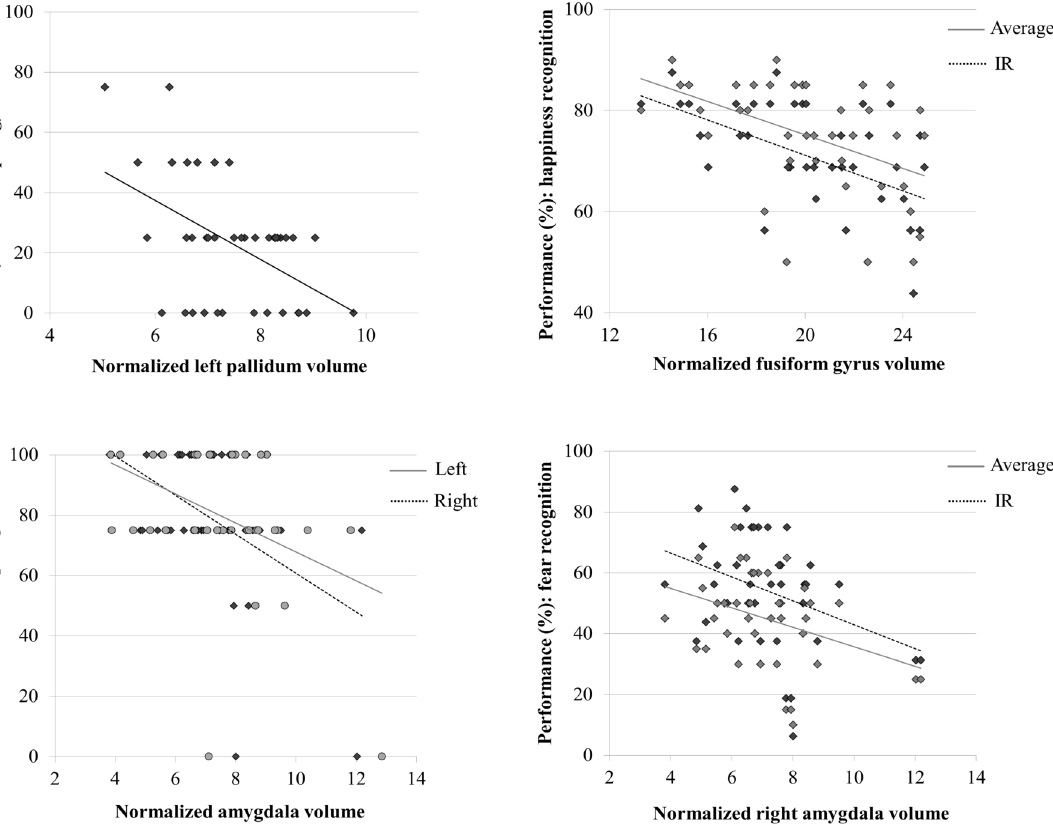
Fig 3. Neuroanatomical correlates of emotion recognition in patients with AD at the MCI stage or at the mild dementia stage. The graphics show the significant correlations between regional volumes normalized by the intracranial volume and performance for disgust recognition (A), happiness recognition (B), and fear recognition (C-D). IR: impaired recognition condition. Measurements were obtained using Pearson ’ s correlation